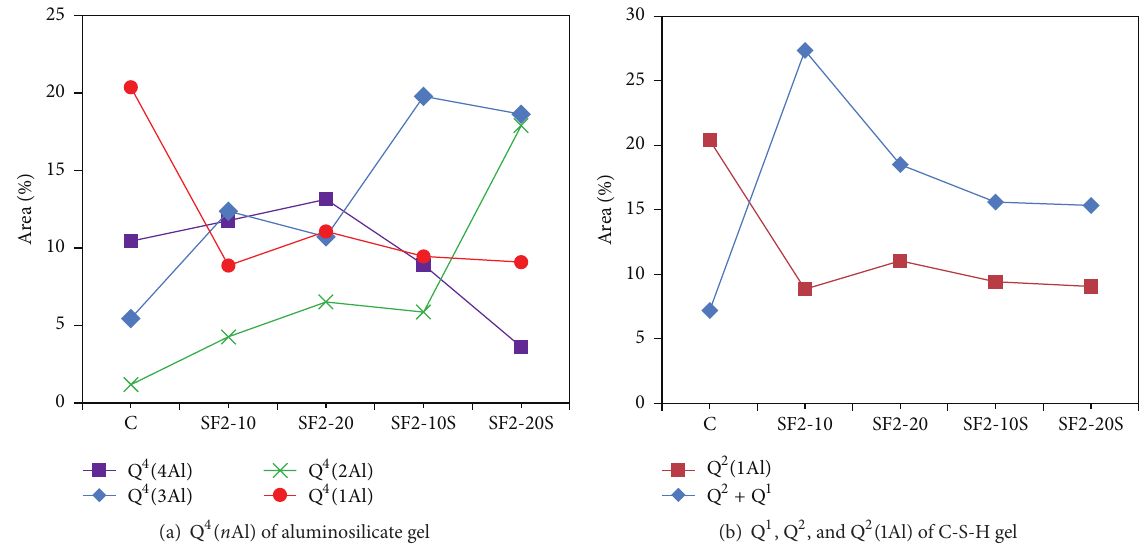
Figure 4: Area (%) of Q 𝑛 components of reaction products derived from Si NMR spectra.